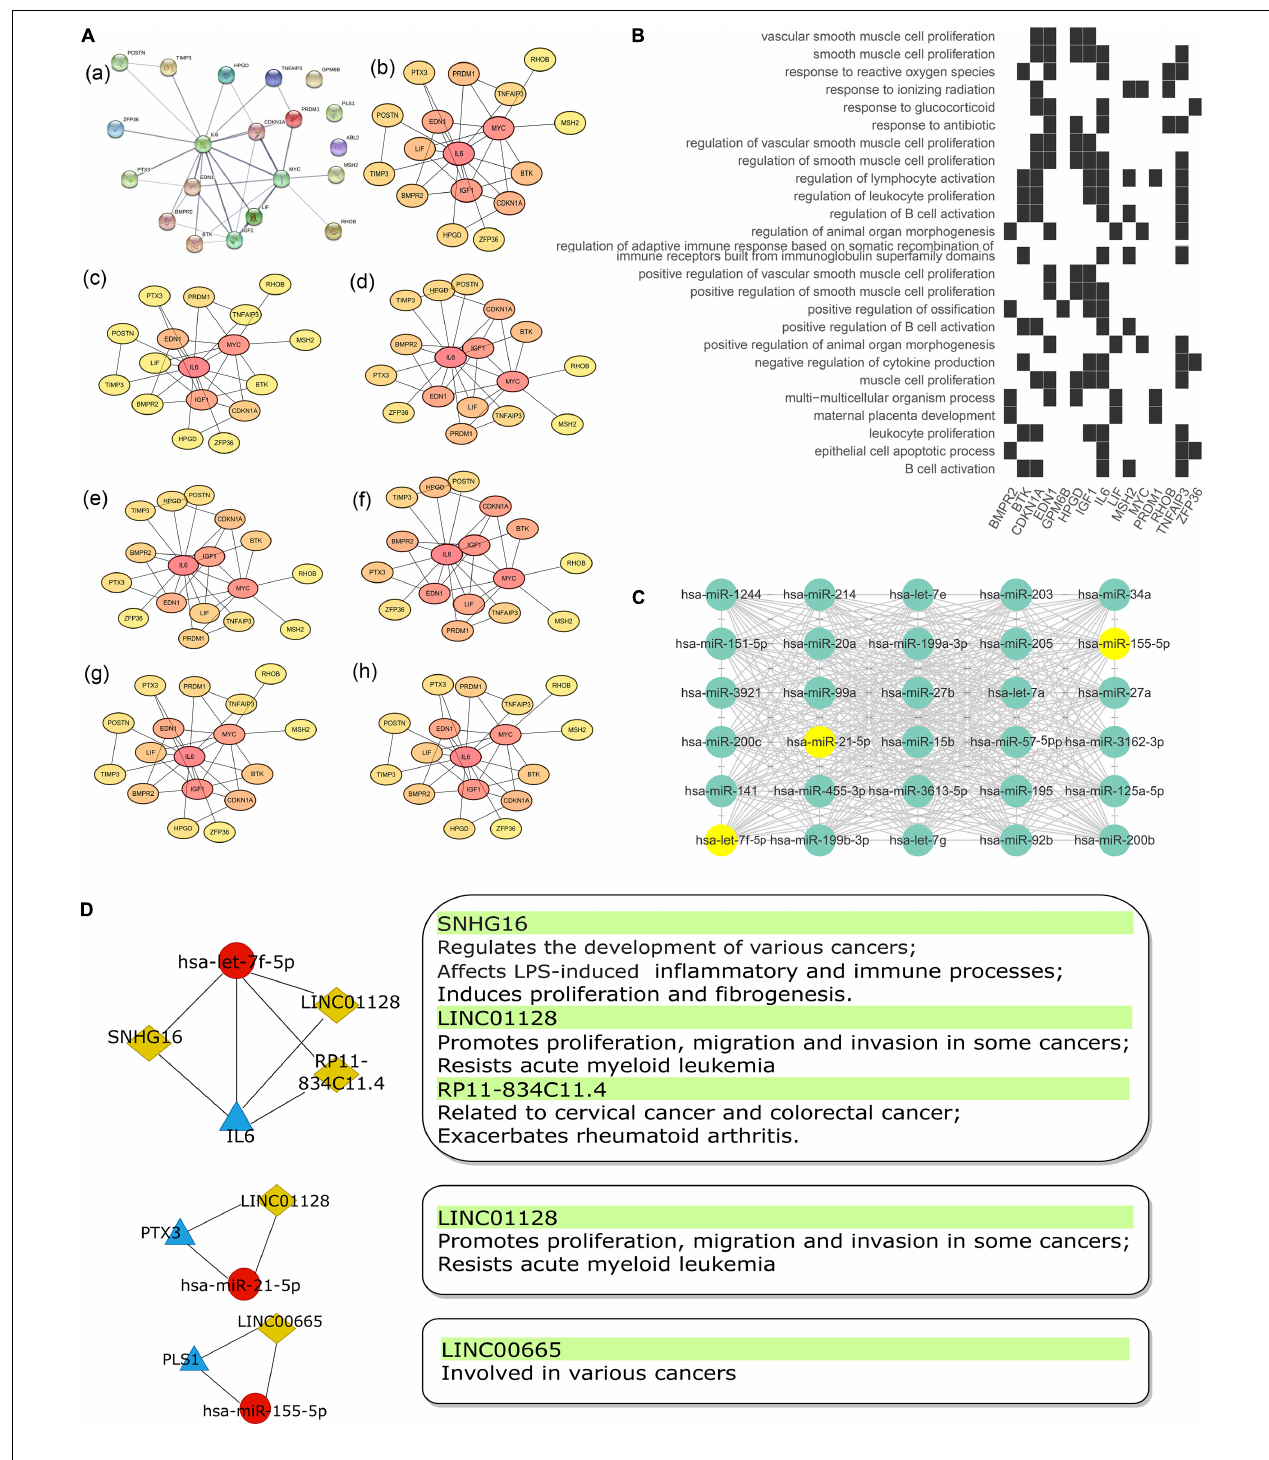
FIGURE 6 | The Sub-network of lncRNA acting as a ceRNA to regulate miRNA–gene pairs in SSc. (A) PPI network (a) of 20 mRNAs in the ceRNA network were analyzed by “cytohubba” plug-in in cytoscape software with seven algorithm methods, including “Radiality” (b) , “Betweenness” (c) , “Closeness” (d) , “EPC” (e) , “MCC” (f) , “MNC” (g) , and “Degree” (h) . (B) Heatmap of enrichment analysis results of 20 mRNAs in ceRNA network. (C) Top 30 key miRNAs in the turquoise module of the co-expression network in GSE81293. Points where 30 key miRNAs overlap with miRNAs in ceRNA network are marked in yellow. (D) The sub-networks of let-7f-5p/IL-6 pair, miR-21-5p/PTX3 pair, and miR-155-5p/PLS1 pair. The left pipeline are the sub-networks of three experimentally supported miRNA–gene pairs in SSc and their linked lncRNAs. The right pipeline are the summarized functions of lncRNAs. PPI, protein–protein interaction; SSc, systemic